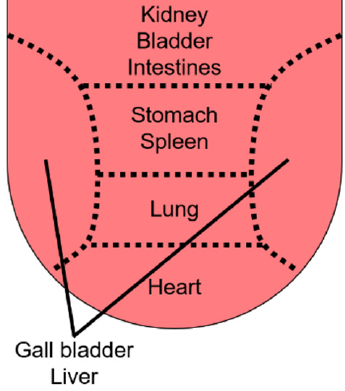
Figure 1. Areas of the tongue corresponding to different internal organs.